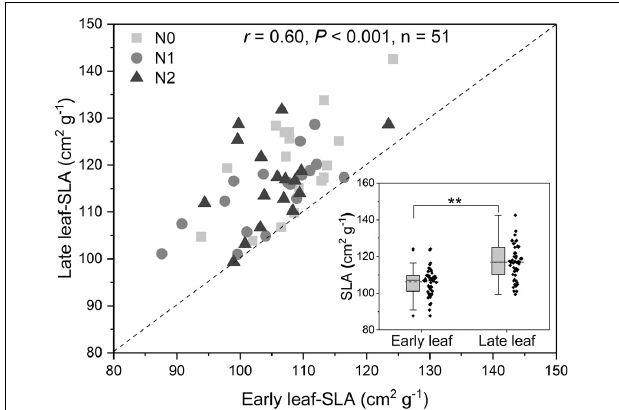
FIGURE 3 | Relationship between specific leaf area ( SLA ) of early leaves and late leaves, and (inset) differences in SLA between the leaf types (In the box plots, the horizontal line represents the median, the box represents the 25–75% interval, whiskers represent the 95% confidence interval, and dots outside this range represent outliers; ** represent significant at P < 0.01, t -test). The r -value is Pearson’s correlation coefficient. N addition ( n = 17 for each treatment): N0 (control), with no N addition; N1, 56 g N per individual; N2, 112 g N per individual. The dashed line is y = x . The points represent SLA -values for the same individual plants; that is, each point represents the mean SLA for all sampled leaves from that plant.